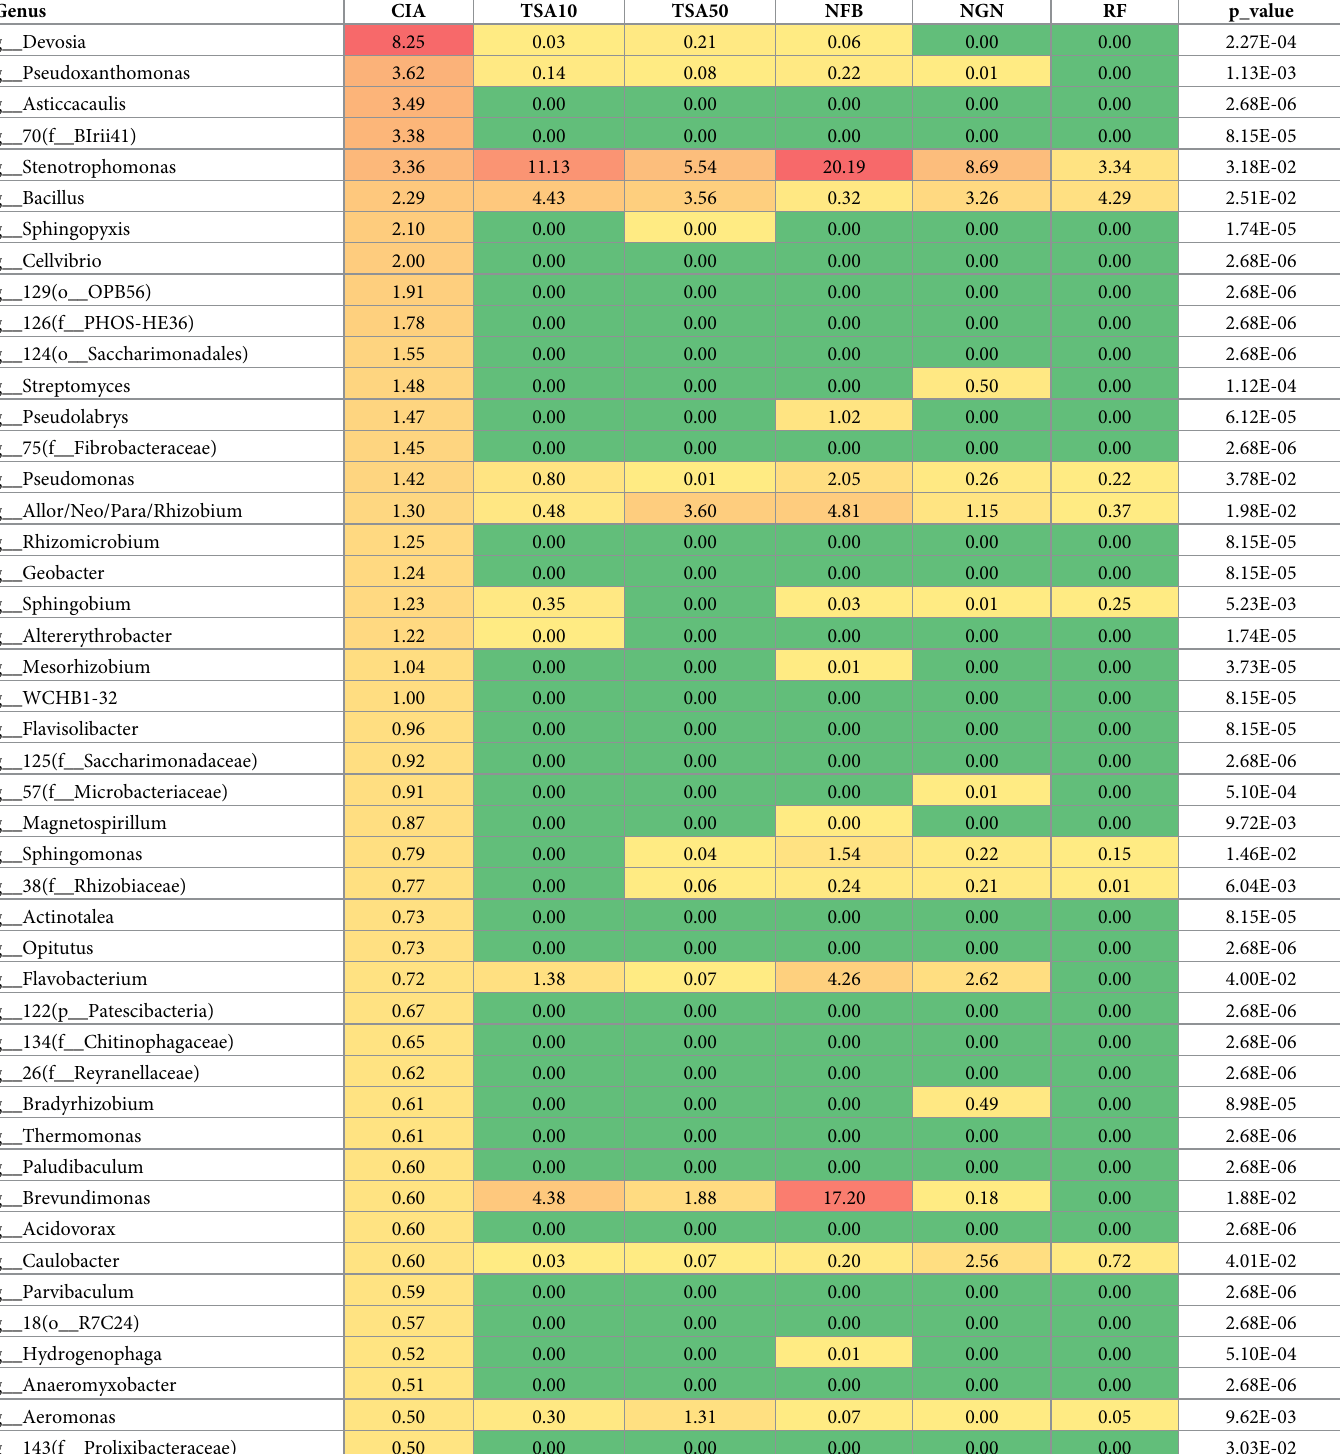
Table 2. List of the top 50 most abundant bacterial genera in the culture-independent approach (CIA), and their occurrence in media of the culturable-dependent approach (CDA). Genus CIA TSA10